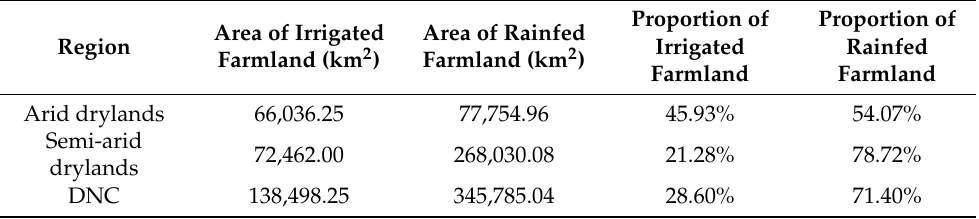
Table 1. The proportion of irrigated farmland and rainfed